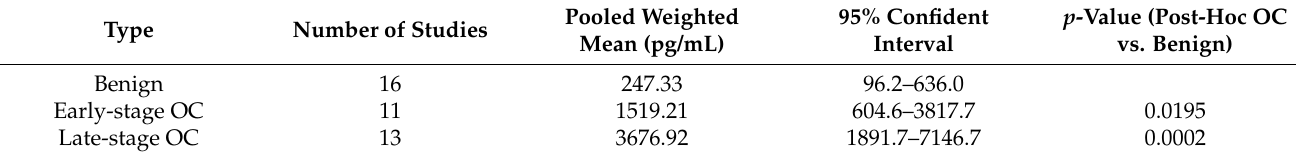
Table 2. The pooled weighted means of IL6 levels in ascites with 95%